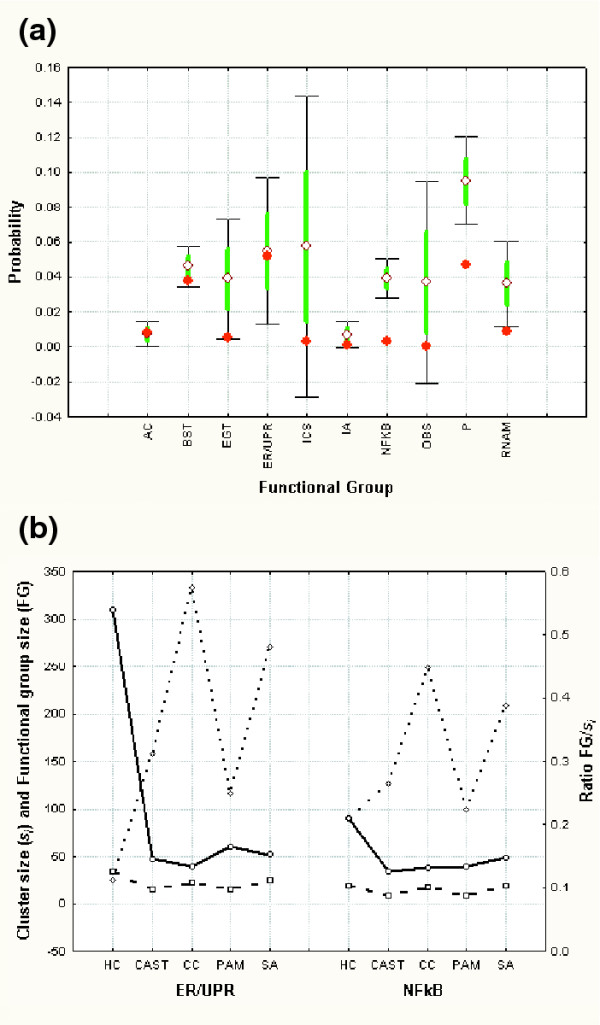
Probability scores and cluster size. (a) The lowest probability scores determined for clusters containing the following functional group signature genes were identified: AC, actin cytoskeleton; BST, B-cell signal transduction; EGT, ER/Golgi trafficking; ERUPR, ER stress/unfolded protein response; ICS, immunoglobulin class switching; IA, inflammation and adhesion; NFκB, NFκB signaling; OBS, other B-cell signaling; P, proliferation; RNA, RNA maturation and splicing. The mean (open diamond), standard error (green line) and standard deviation (thin black line and bars) of the minimum probability scores for SA, CAST, HC and PAM are shown together with the minimum probability score for the corresponding consensus cluster (red circle). (b) The cluster size (si) (open circles) and number of defining functional group genes (FG) (open squares) for the NFκB signaling and ER/UPR functional groups are shown together with the FG/si ratio (open diamonds).